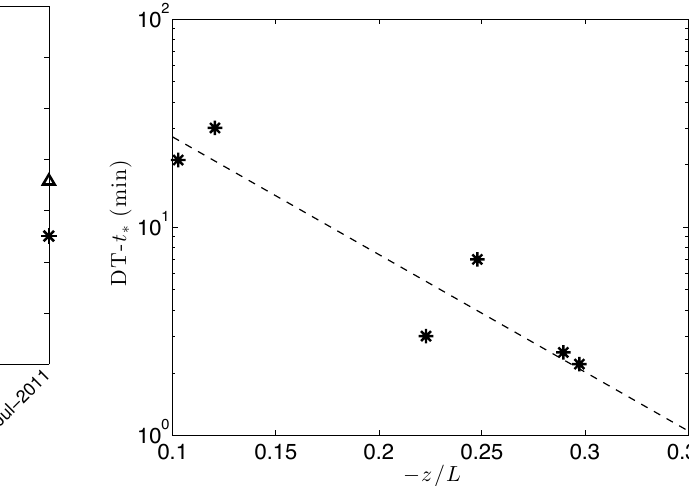
Figure 7. For all the IOPs, difference between the delay and con- vective times as a function of − z/L